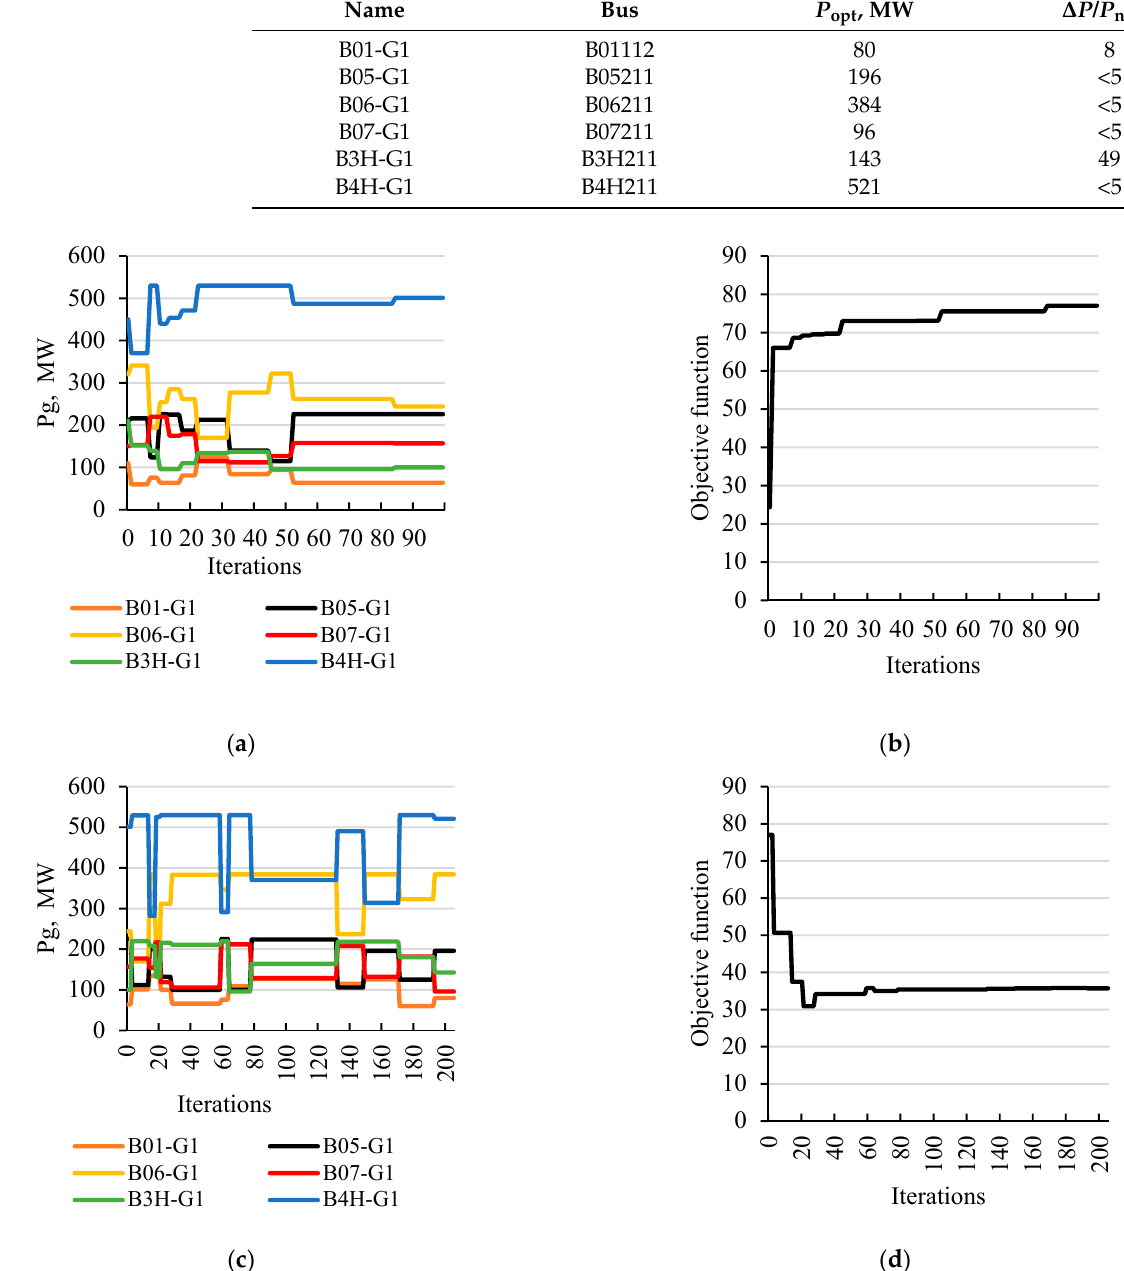
Table 4. List of sources with optimal capacity and expected values of power surges calculated for each generator.